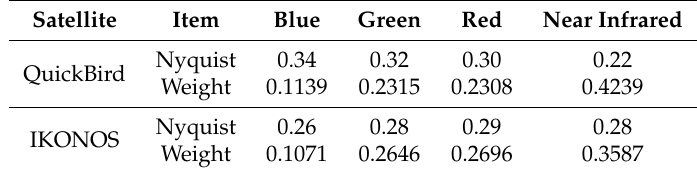
Table 1. Nyquist cutoff frequencies (Nyquist) and linear weights (Weight) of different satellites for each spectral band. Satellite